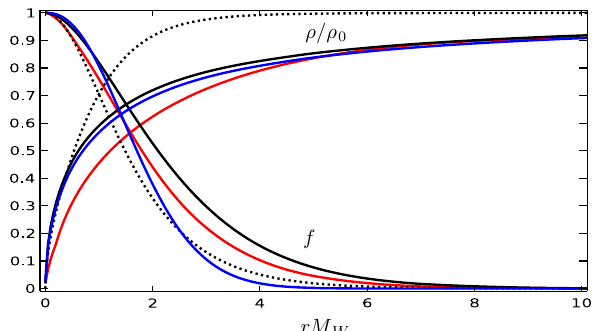
Fig. 7 The BPS electroweak monopole solutions. The black curves represent the solution given by (40), the blue curves represent the solu- tion given by (44), and the red curves represent the solution given by (50). The monopole solution regularized by the real electromagnetic permittivity given by (33) is shown in dotted curves for